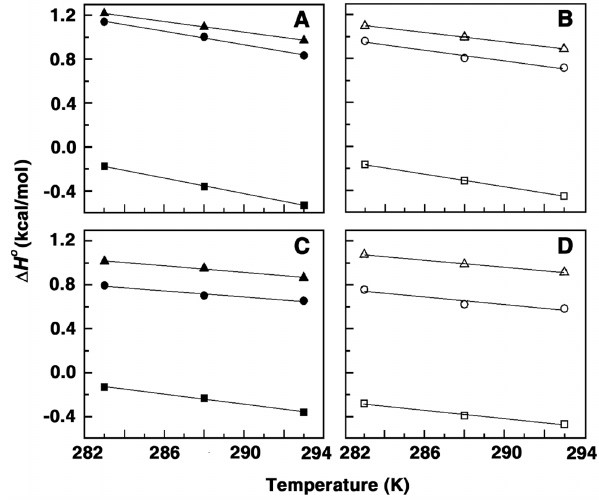
Figure 3. Plot of variation of enthalpy of binding ( D H O ) with N temperature. Plots for the binding of (A) spermine with CP DNA ( & ), ), ML DNA ( m ), (B) spermidine with CP DNA ( % ), EC DNA ( # ), EC DNA ( ML DNA ( n ), (C) putrescine with CP DNA ( & ), EC DNA ( and (D) cadaverine with CP DNA ( % ), EC DNA ( # ), ML DNA ( n ). doi:10.1371/journal.pone.0070510.g003 PLOS ONE |